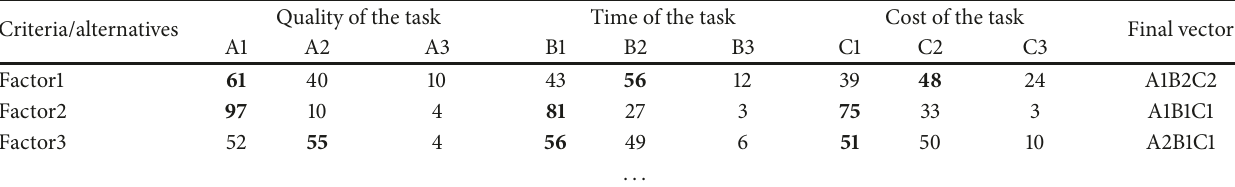
Table 6: Example of alternatives characterisation for requirements tasks.